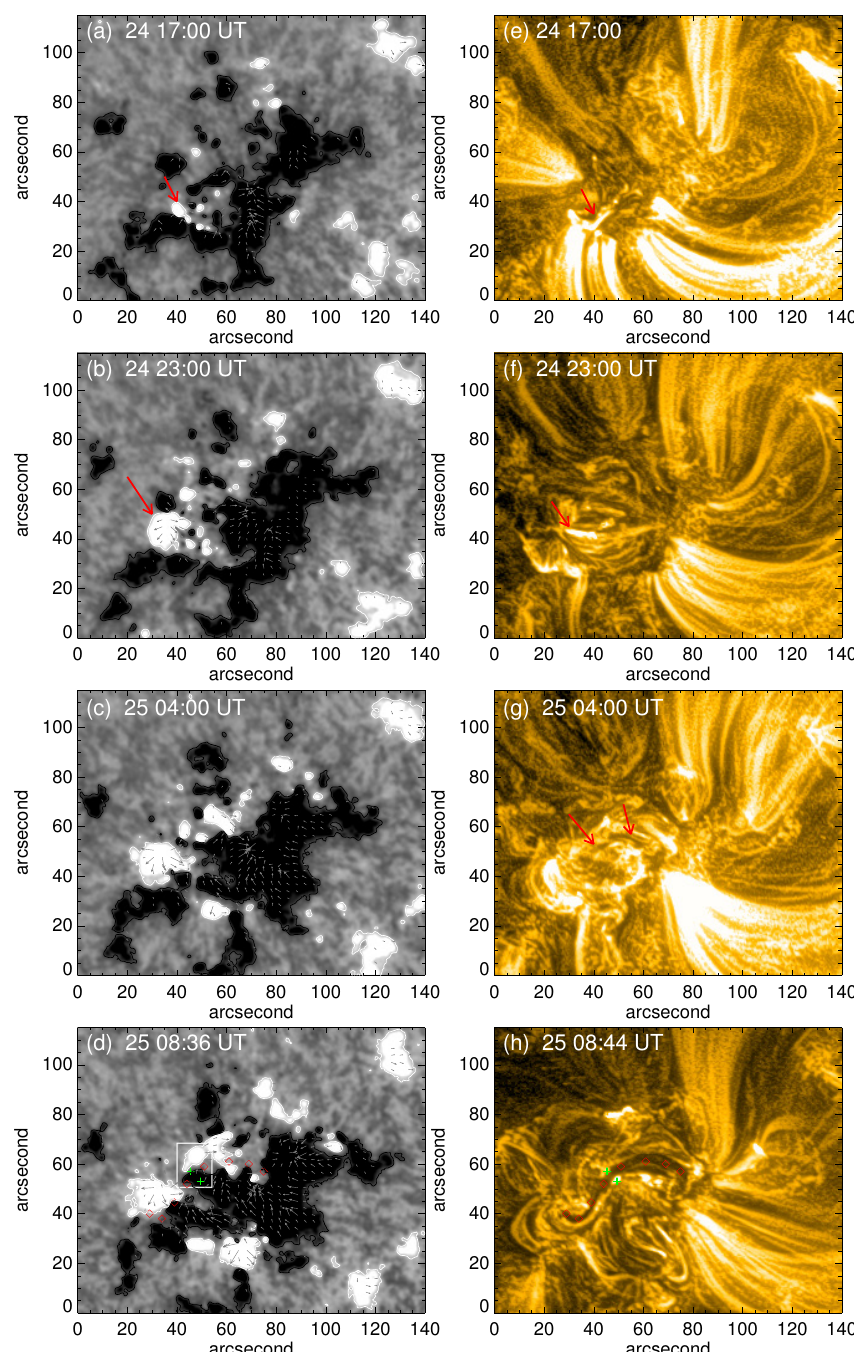
Figure 7. First column (Panel a – d ): SDO/HMI vector magnetograms of active region NOAA 10387 from its early emergence to the filament eruption. The longitudinal component of the magnetic field is represented by gray-scale patches. White (black) represents positive (negative) polarity fields. The transverse components of the field are shown with gray arrows, with lengths proportional to the relative field strength. Red arrows indicate the emergence of opposite polarities along the PIL; second column (Panel e – h ): AIA 171 Å image. Red arrows in upper two rows indicate the EUV brightening spatio-temporal with the opposite polarities emergence and cancellation along the PIL. Red arrows in third row indicate dark thread along the PIL. Red diamonds outline the profile of the filament and green pluses indicate the initial EUV